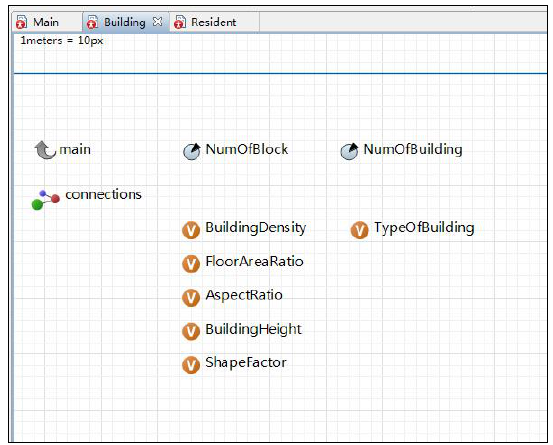
Figure 2. The setting of urban morphology variables.